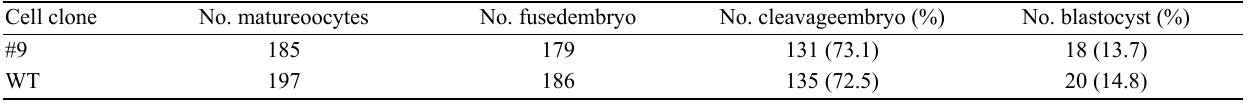
Table 1. In vitro development of cloned sheep embryo from TALEN-modified cells Cell clone